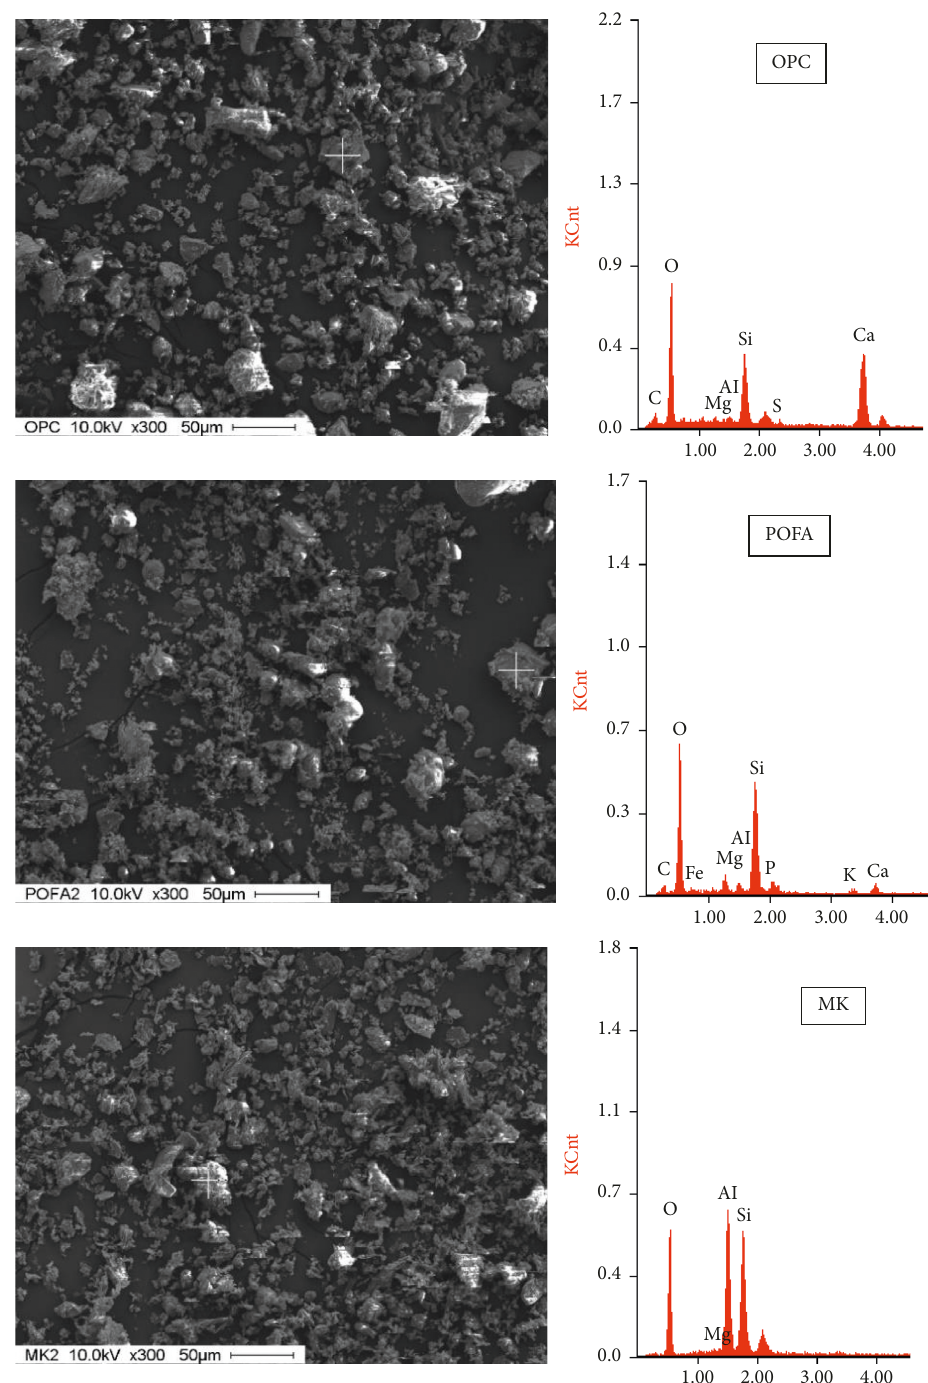
Figure 1: OPC, POFA, and MK element analysis using SEM